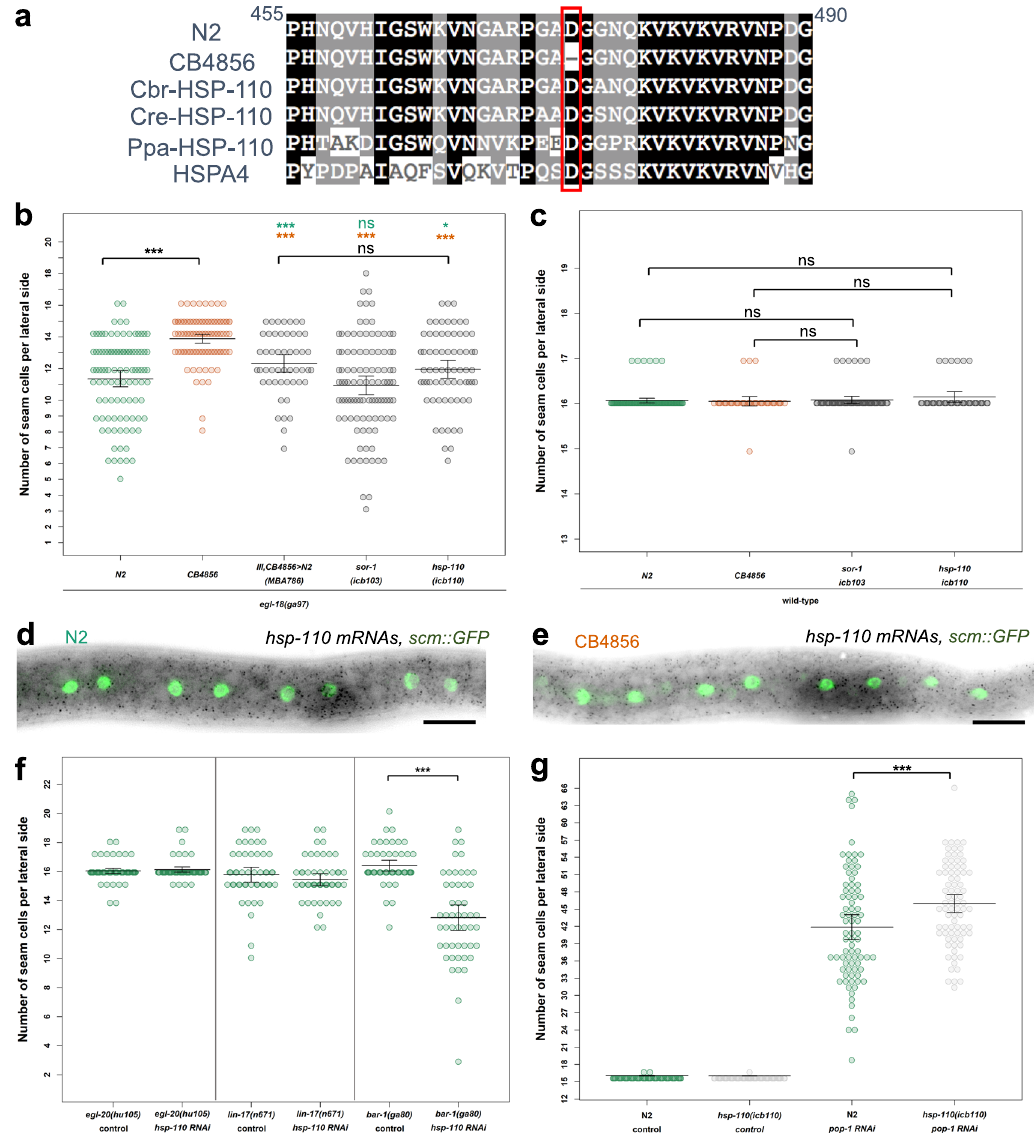
Fig. 6 Natural variation in hsp-110 contributes to the difference in phenotype expressivity between N2 and CB4856. a Alignment of the HSP-110 amino- acid sequence from C. elegans (N2 and CB4856), C. remanei (Cre) , C. brenneri (Cbr) , P. paci fi cus ( Ppa ), and H. sapiens (HSPA4) around the amino-acid deletion in CB4856 (highlighted in red). b – c Comparison of seam cell counts between animals carrying the CB4856 variants of hsp-110 and sor-1 in N2 in the egl-18(ga97) ( b ) or wild-type background ( c ); n > 68 independent animals in ( b ) and n > 40 independent animals in c . Comparison is shown to parental isolates or the introgression of the QTL on chromosome III as a reference. Signi fi cance is tested by one-way ANOVA followed by post hoc Tukey HSD and differences are shown compared with N2 (green stars) and CB4856 (orange stars) respectively, *** corresponds to p < 0.001. d – e Representative smFISH images showing hsp-110 expression in divided seam cells in N2 or CB4856 at the late L2 stage. Seam cell nuclei are labelled in green due to scm::GFP expression and black spots correspond to hsp-110 mRNAs. A similar pattern of expression was observed in two independent experiments. Scale bar is 20 µ m. f SCN quanti fi cation in N2 carrying mutations in Wnt components upon knockdown of hsp-110 , ( n > 49 independent animals for all strains, signi fi cance is reported with a two-tailed Welch t test; p = 0.31 for lin-17(-), p = 0.43 for egl-20(-) and p < 0.0001 for bar-1(-) mutants). Vertical lines mark independent experiments. g SCN quanti fi cation in N2 or N2 carrying the CB4856 hsp-110 allele upon knockdown of pop-1 ( n = 80 independent animals). Signi fi cant change is found upon pop-1 RNAi treatment ( p = 0.0008 by one-way ANOVA followed by post hoc Tukey HSD). Error bars in b – c , f – g indicate 95 % con fi dence intervals around the mean. Source data are provided as a Source Data fi